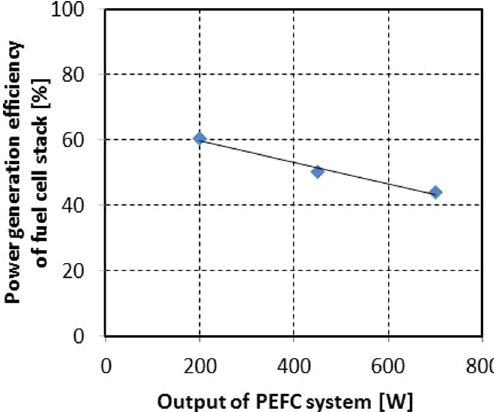
Fig. 3. Partial load ef fi ciency of the fuel cell stack.